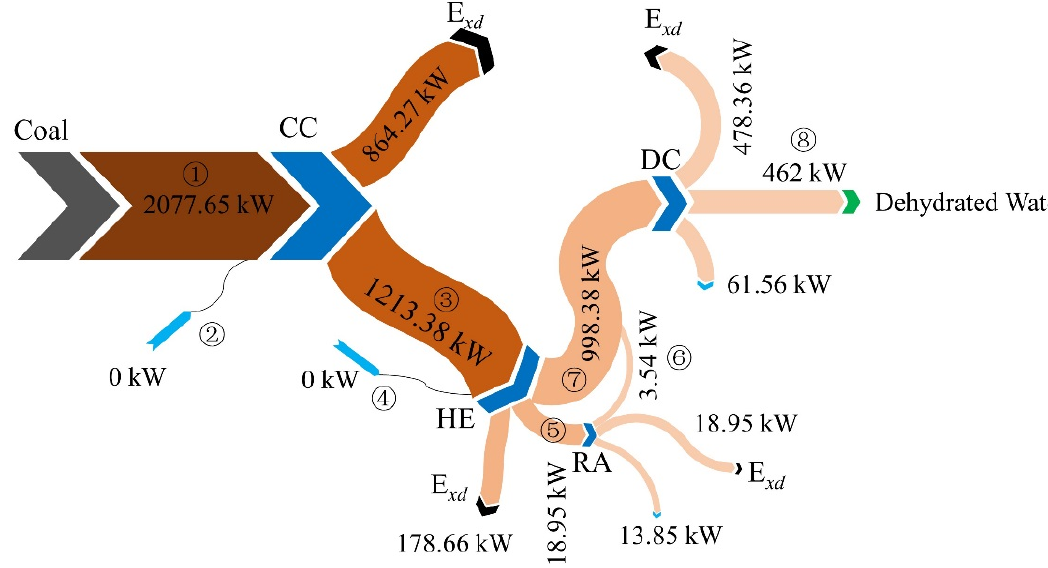
Figure 12. Sankey diagram of the overall drying system assisted by the exergy analysis.